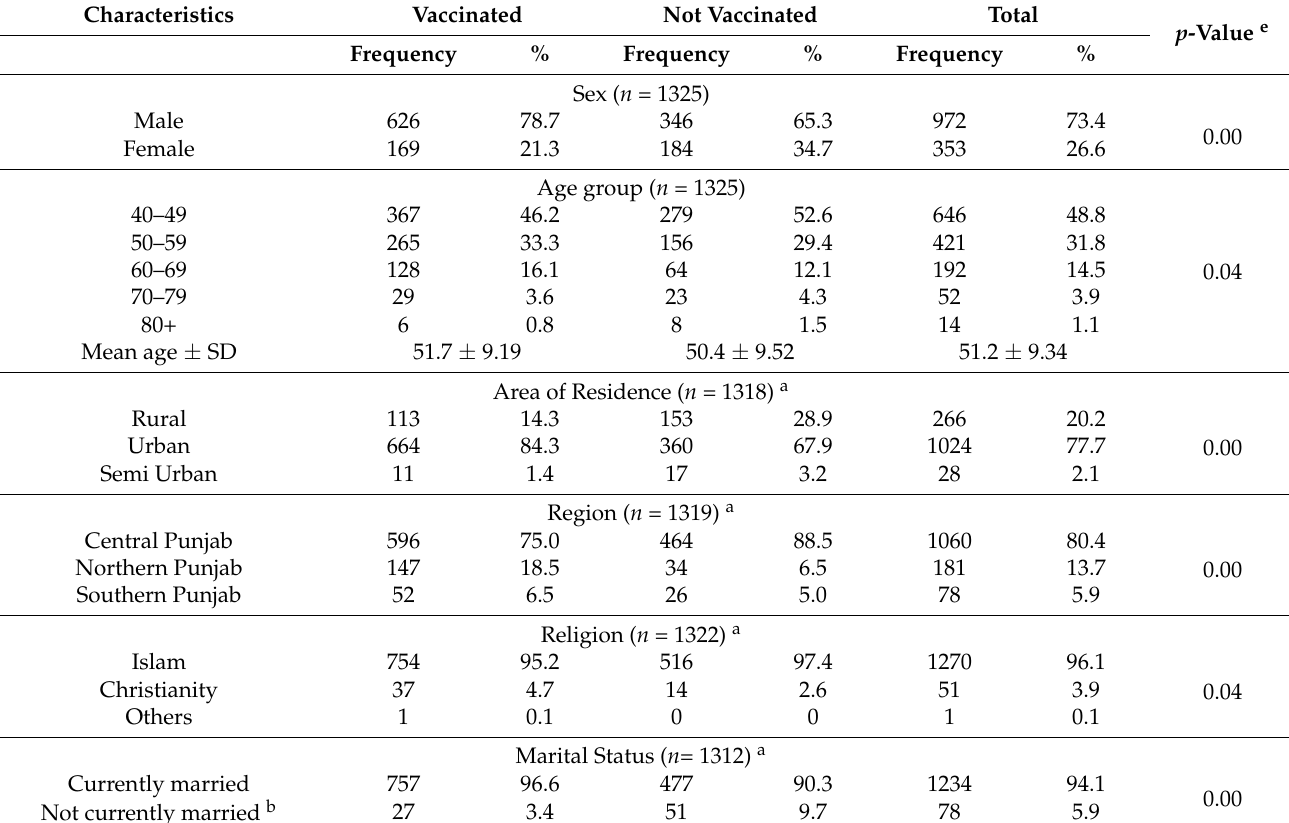
Table 1. Socio-demographic status of respondents by their vaccination status ( n =